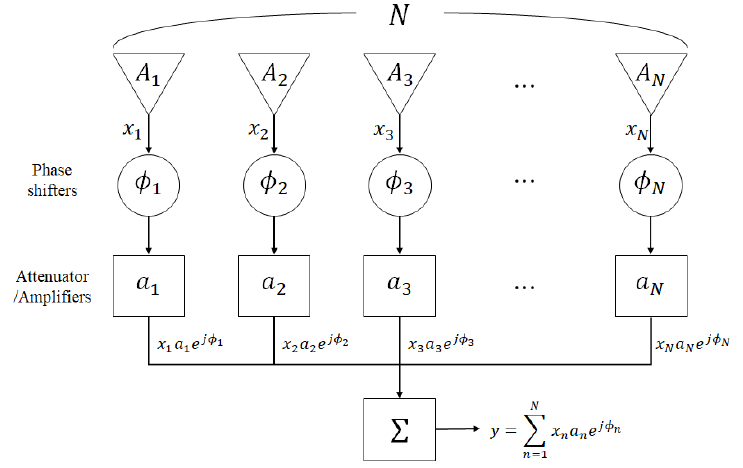
Figure 2. Schematic layout of array